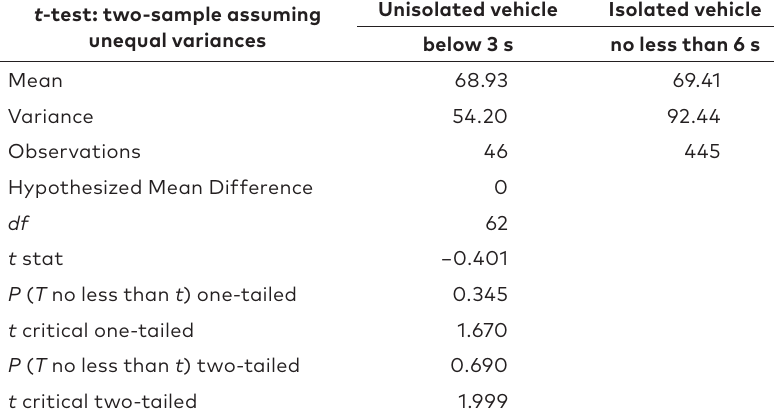
Table 3. Descriptive statistics for Site 1